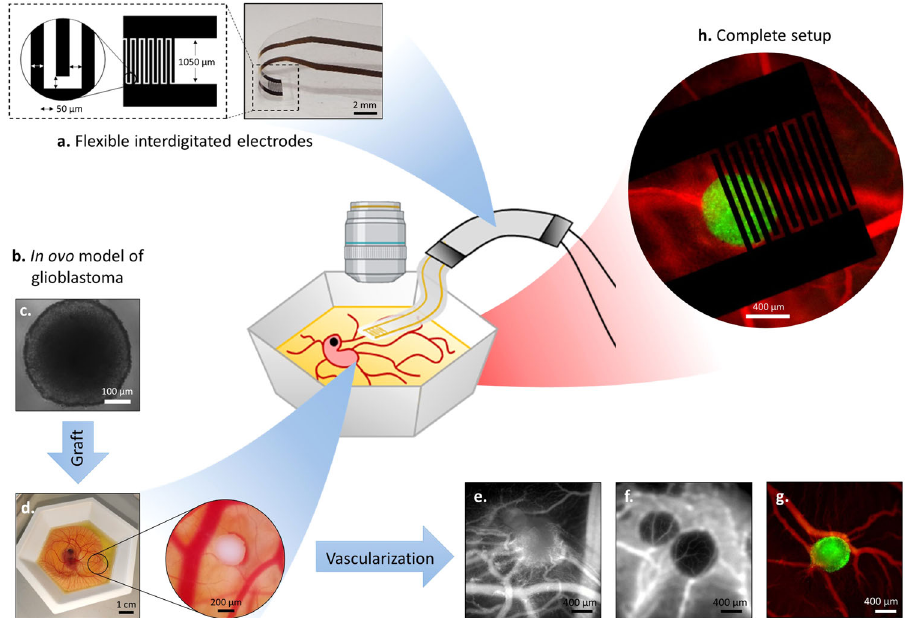
Fig. 1 Integration of fl exible electronics onto a vascularized 3D tumor model. a Flexible interdigitated electrodes and the scheme of the tip. b Steps of the development of the in ovo model of glioblastoma. c Spheroid of U87 cells obtained by 3D cell culture observed under the microscope. d Shell-less culture of a quail embryo with a zoom on the grafted spheroid. e – g pictures of vascularized spheroids observed by fl uorescence microscopy. On e and f , vasculature was visualized by injecting Texas Red dextran into the circulation. On ( g ) in addition to the intravascular injection of Texas Red dextran in the circulatory system (red), spheroid was labeled intravitally with a viability marker (green). h Flexible interdigitated electrodes placed on the in ovo model of glioblastoma, observed by fl uorescence microscopy with the same markers than ( g ). Scale bars: a 2 mm, c 100 µm, d left: 1 cm, right: 200 µm, e – h 400